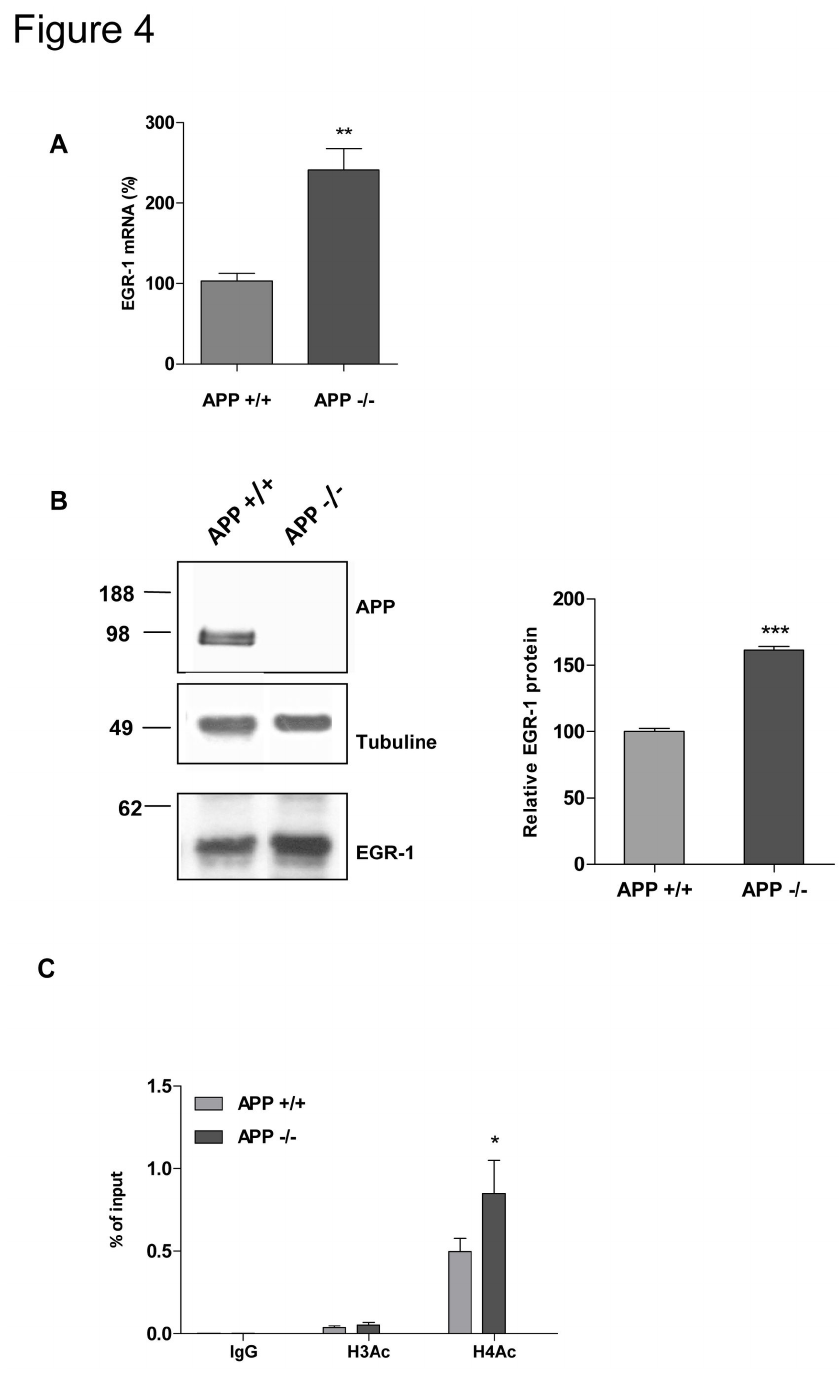
Figure 4. APP controls EGR-1 expression in vivo . A ) EGR-1mRNA levels were quantified by q-RT PCR in mouse cortex (n=9). Values were normalized to the GAPDH mRNA, and expressed as percentage of the APP+/+ tissue. Student’s t-test: ***p < 0.001. B ) EGR-1 protein expression was detected by Western blot analysis of extracts obtained from cortex of APP +/+ and APP -/- mice, 5 months of age (n=5). Typical blot is shown with anti-tubulin utilized as a loading control. EGR-1/tubulin ratio were quantified, and expressed as percentage of the APP+/+ mice. Student’s t-test : ***p<0.001. Data are expressed as mean ± SEM.C) Chromatin immunoprecipitations of EGR-1 promoter were performed on chromatin isolated from mice cerebral cortex (n=7) with normal IgG as negative control, anti-acetylated H3 antibody, or anti-acetylated H4 antibody. Immunoprecipitated DNA was quantified by qPCR and normalized to the input. Two way Anova, n.s. non-significant, *p<0.05. doi: 10.1371/journal.pone.0074305.g004 PLOS ONE |